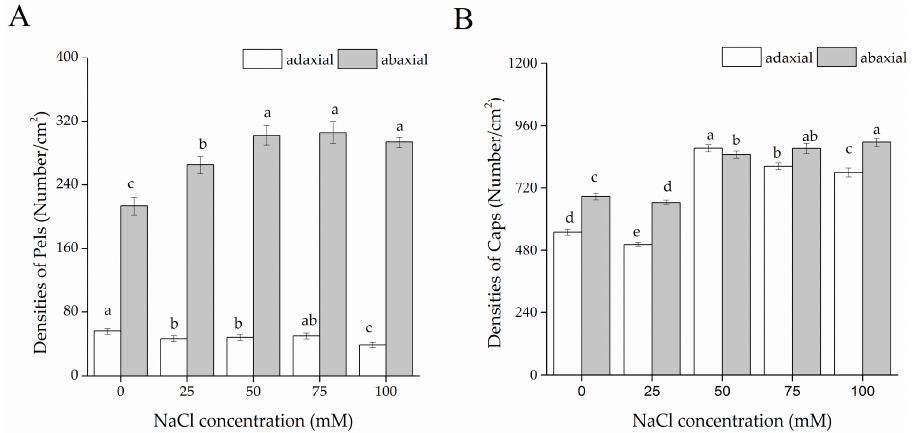
Figure 4. Effects of salt stress on the densities of glandular tricomes on leaves of S. tenuifolia . ( A ) Densities of Pels on both leaf surfaces; ( B ) Densities of Caps on both leaf surfaces. Data are expressed as the means ± SD. Bars filled in the same color with different letters are significantly different at p < 0.05 ( n = 15).